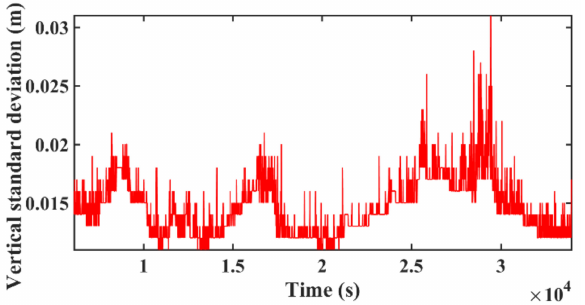
Figure 9. The standard deviation of each epoch in the vertical direction.